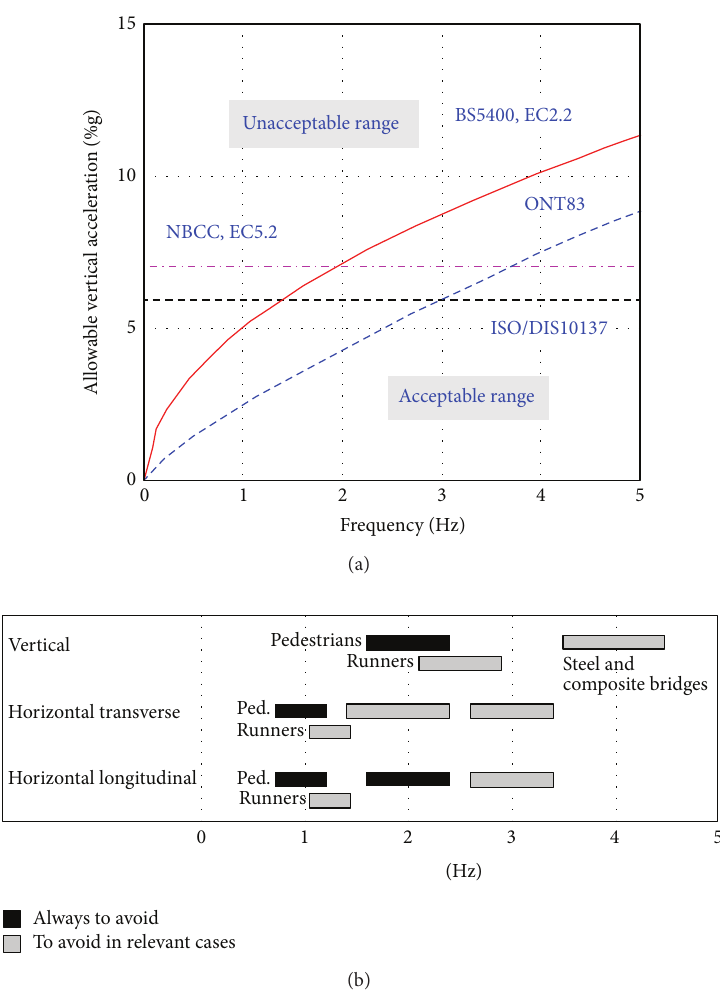
Figure 10: (a) Allowable vertical accelerations as a function of frequency of vertical mode [26], (b) frequencies to be avoided [14,